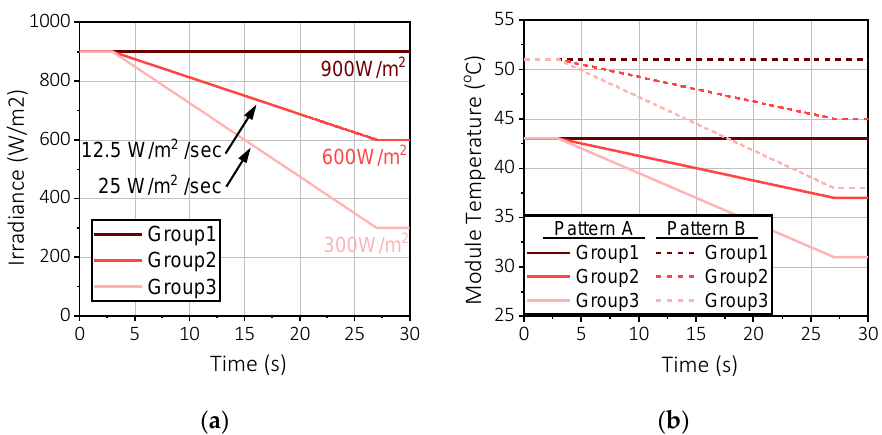
Figure 5. ( a ) Irradiance and ( b ) temperature variation with time for the three PV groups of the VMPV architecture.